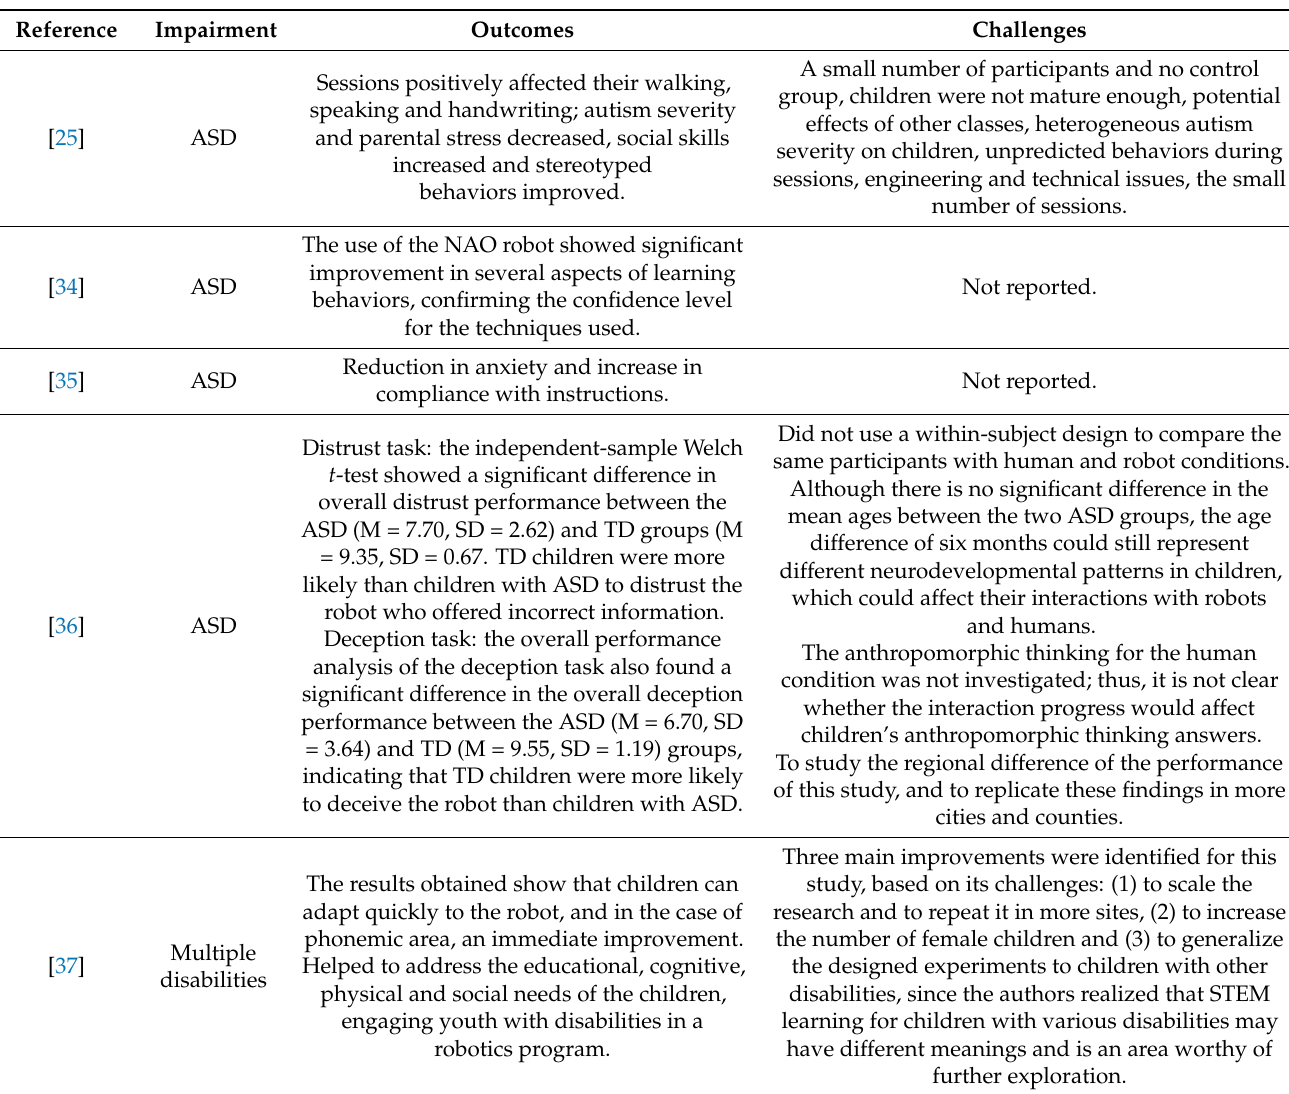
Table 5. Main reported outcomes and challenges of some of the examined